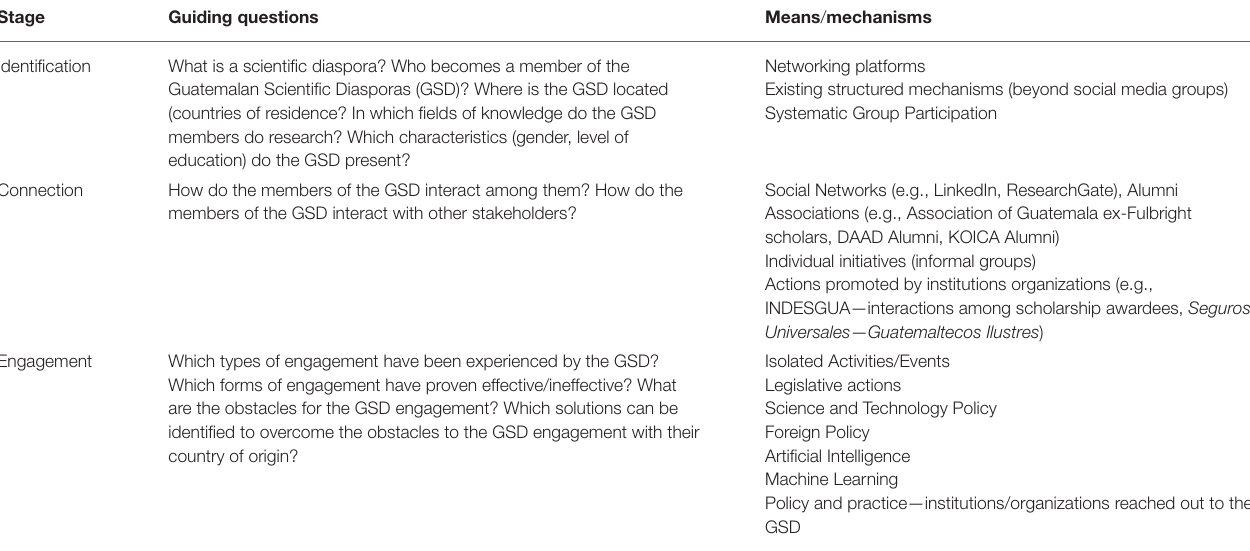
TABLE 6 | Framework for data analysis—stages in engaging with the GSD.